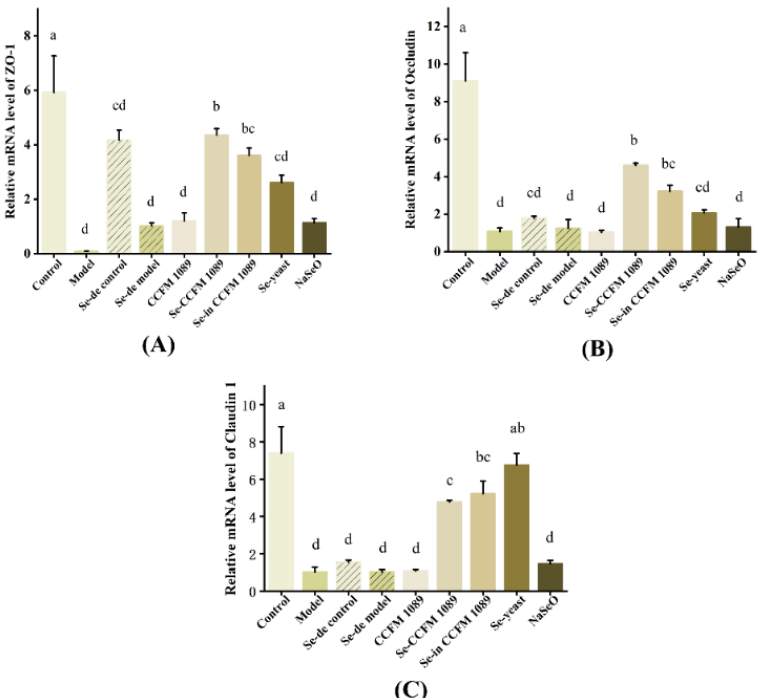
Figure 9. Expression of tight junction proteins ZO-1, occludin, and claudin-1 in colon. ( A ) ZO-1, ( B ) Occludin, ( C ) Claudin-1. Graphs show mean ± SD; n = 5. Significant differences are indicated by different superscript letters ( p < 0.05), and the same superscript letters above the bars indicate that the differences between the values are not statistically significant ( p > 0.05).